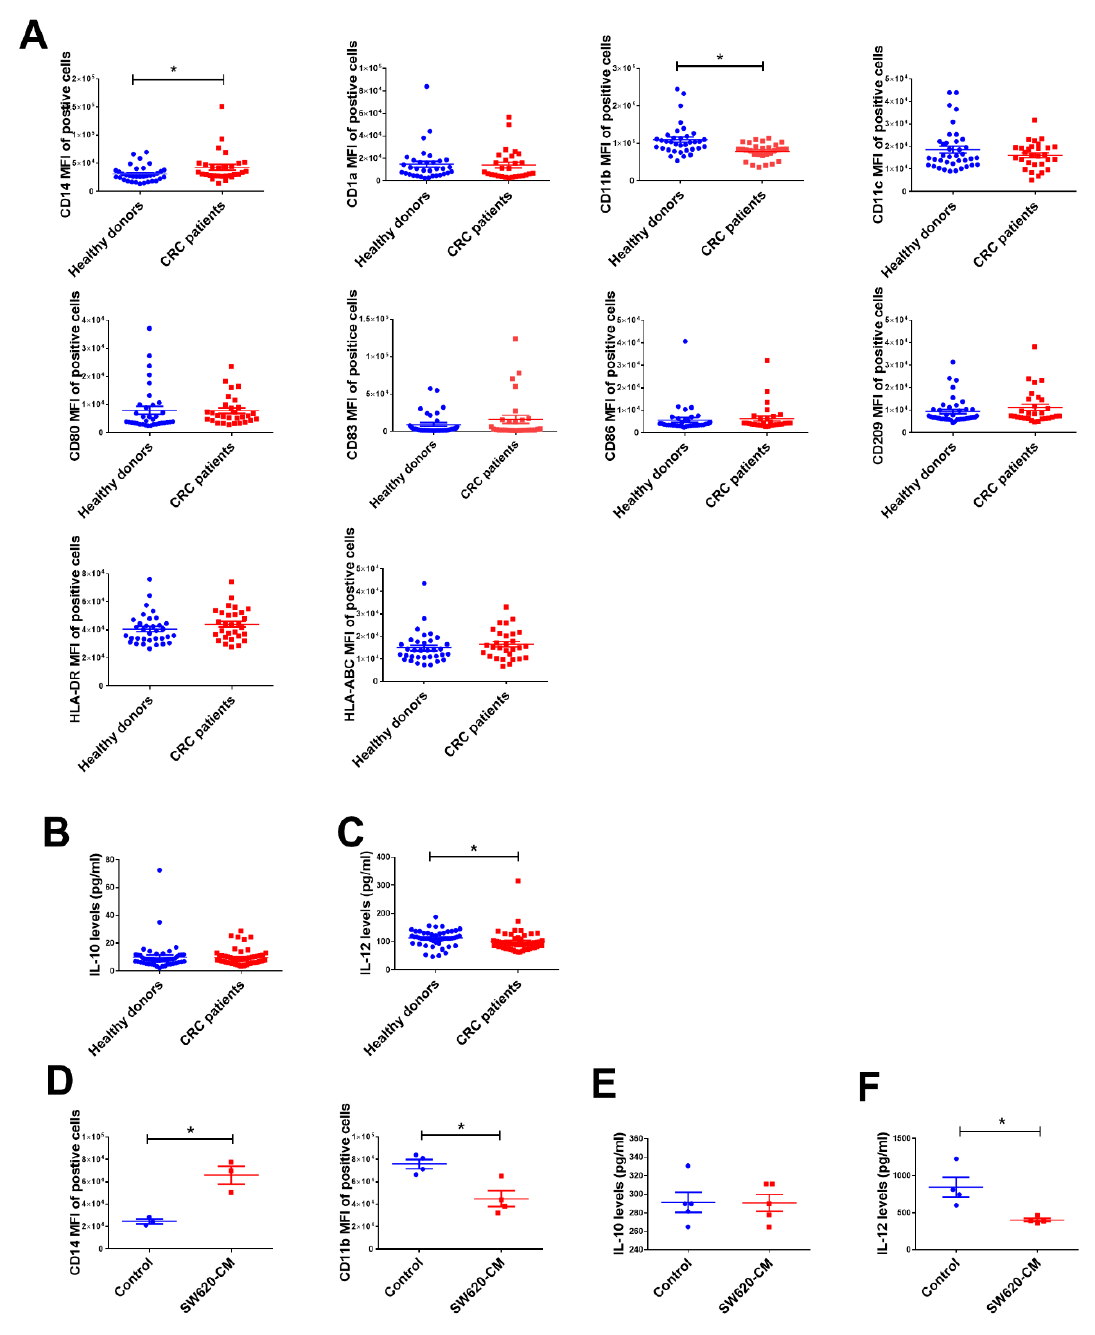
Figure 1. The dendritic cell (DC) phenotype of colorectal cancer (CRC) patients. ( A ) The changes in surface marker expression of DCs isolated from healthy donors and patients with CRC. The levels of IL-10 ( B ) and IL-12 ( C ) in DCs. CD11c + cells were isolated from healthy donors and patients with CRC, the surface markers of the cells were determined by flow cytometry after staining (shown as mean fluorescence intensity (MFI)), and the levels of IL-12 and IL-10 were measured by Luminex assay. ( D ) The phenotype of SW620-conditioned tumor-associated DCs (TADCs). The levels of IL-10 ( E ) and IL-12 ( F ) in TADCs. CD14 + monocytes were cultured in RPMI-1640 containing GM-CSF (10 ng/mL) and IL-4 (10 ng/mL) with or without L-15 medium or SW620-condition medium (SW620-CM, 50%) for five days. Results are representative of at least three independent experiments. Each value is the mean ± SD of three determinations. * Significant difference between the two test groups ( p < 0.05) (*).